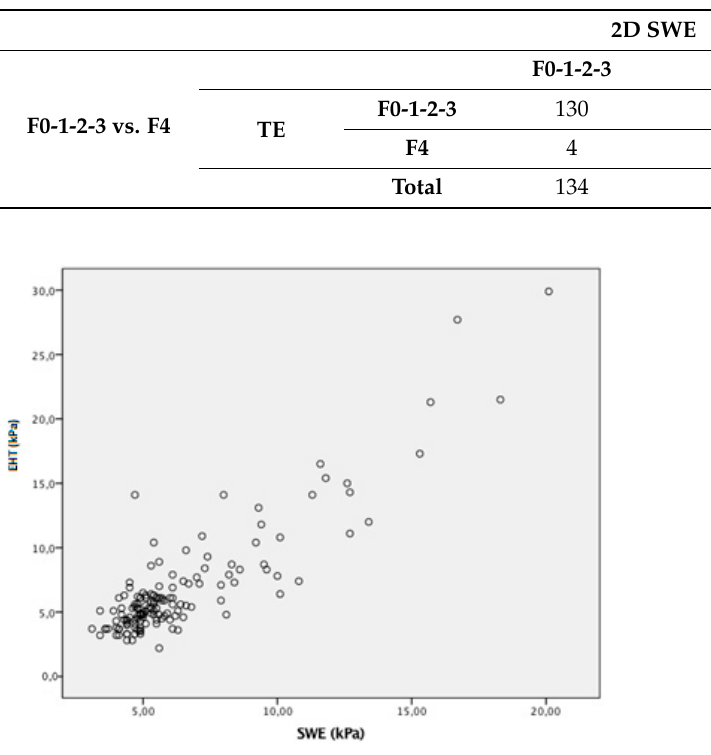
Figure 1. Scatter plot of distribution of transient elastography (TE) vs. 2D-shear wave elastography (2D-SWE).